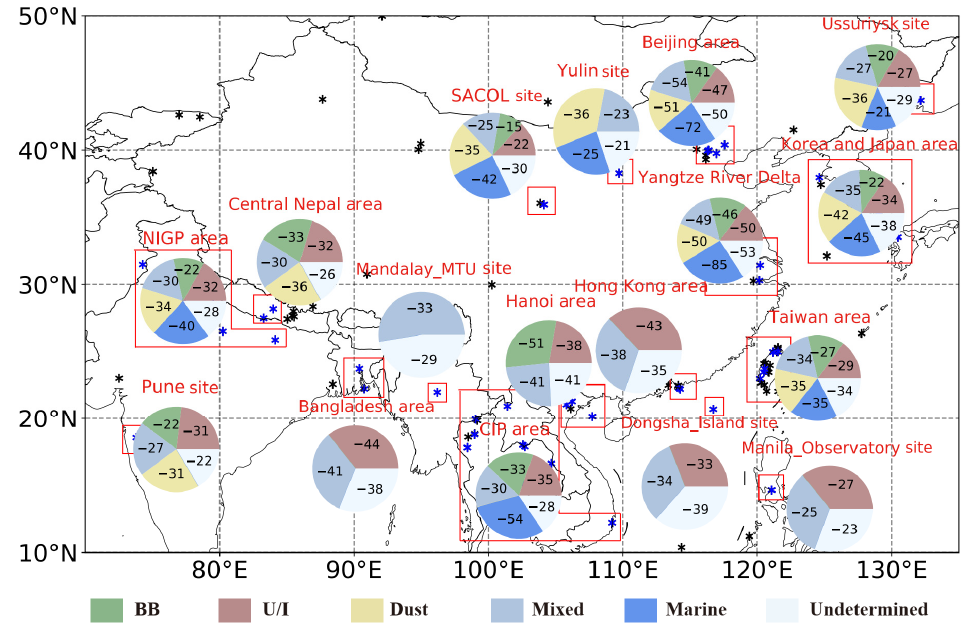
Figure 9. The daily averaged ARF TOA for various aerosol types based on the MD classification method. The numbers in the pie chart indicate the averaged ARF of the corresponding aerosol type (Unit: W/m 2 ). The blue asterisks on the map indicate the locations of the sites used for analysis, while the black ones represent the sites that are not used.